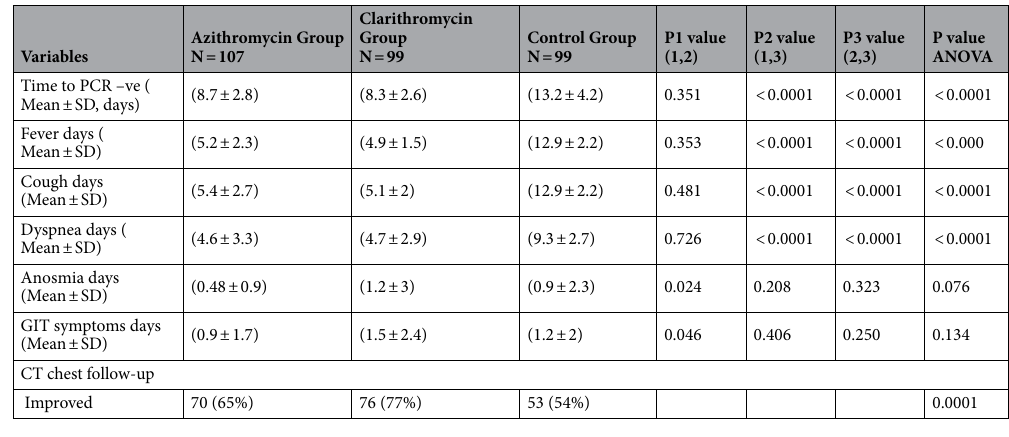
Table 2. Duration of symptom improvement and PCR conversion to negative in the study groups among patients with mild COVID-19. P1 = Azithromycin treated group versus clarithromycin treated group. P2 = Azithromycin treated group versus control group. P3 = clarithromycin treated group versus control